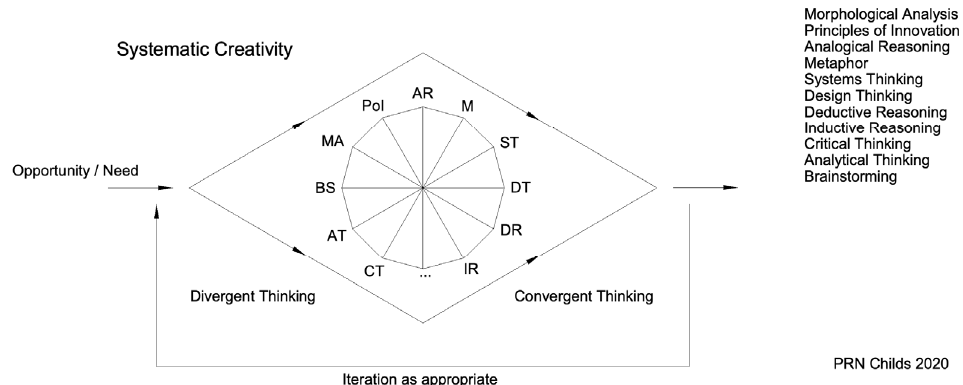
Figure 10. Creativity diamond